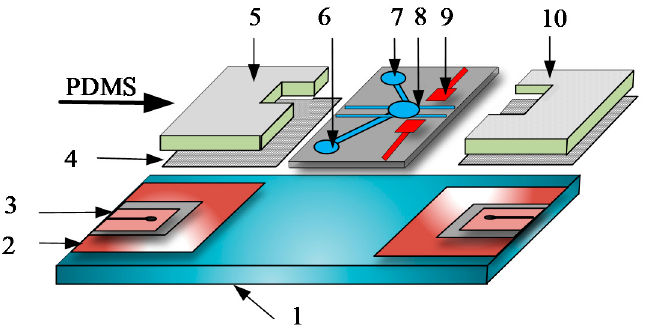
Figure 25. Schematic representation of the integrated microfluidic system (adopted from [95]). The microelectrodes deposited on the lower substrate act as driving elements, while the ones on the shielding channel are for the mixing of samples. 1 –glass substrate, 2 –micro heater, 3 –integrated temperature sensor, 4 –cover slide, 5 –micro lysis reactor, 6 –PCR reagent injection, 7 –primer injection, 8 –mixture reservoir, 9 –mixer, 10 –micro PCR camber.